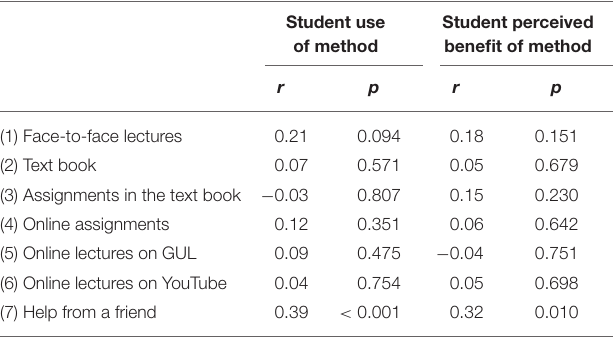
TABLE 1 | The relationship between Math anxiety and use as well as perceived benefit for the seven different methods for teaching and learning ( n = 65). Student use of